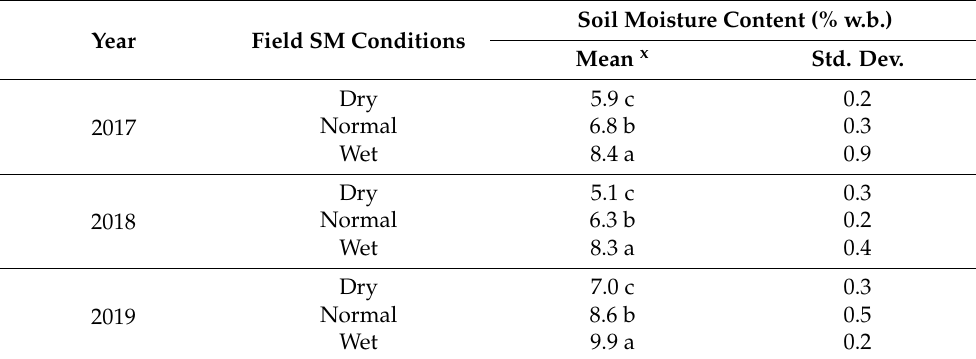
mean air temperature, soil temperature, and total rainfall during the month of May and June in 2017, 2018 and 2019 are presented in Figure A1 in Appendix A. Table 2. Mean soil moisture content and standard deviation values for the dry, normal and wet field